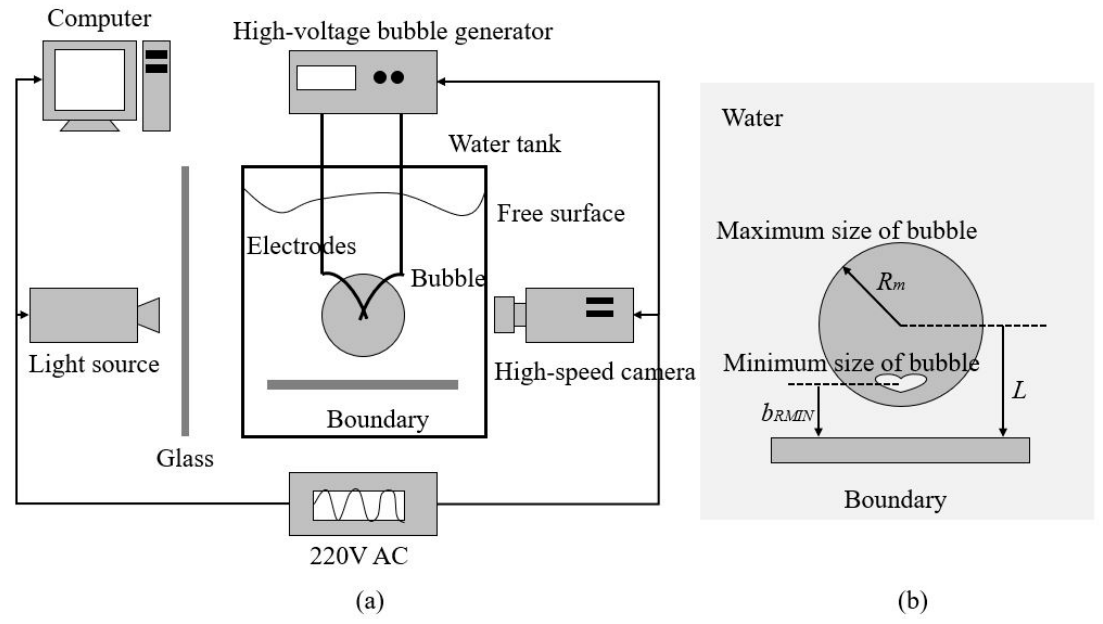
Figure 1. ( a ) Schematic diagram of the experimental equipment, including the high-speed camera system and bubble generator; ( b ) details regarding the position of a bubble relative to the plate in